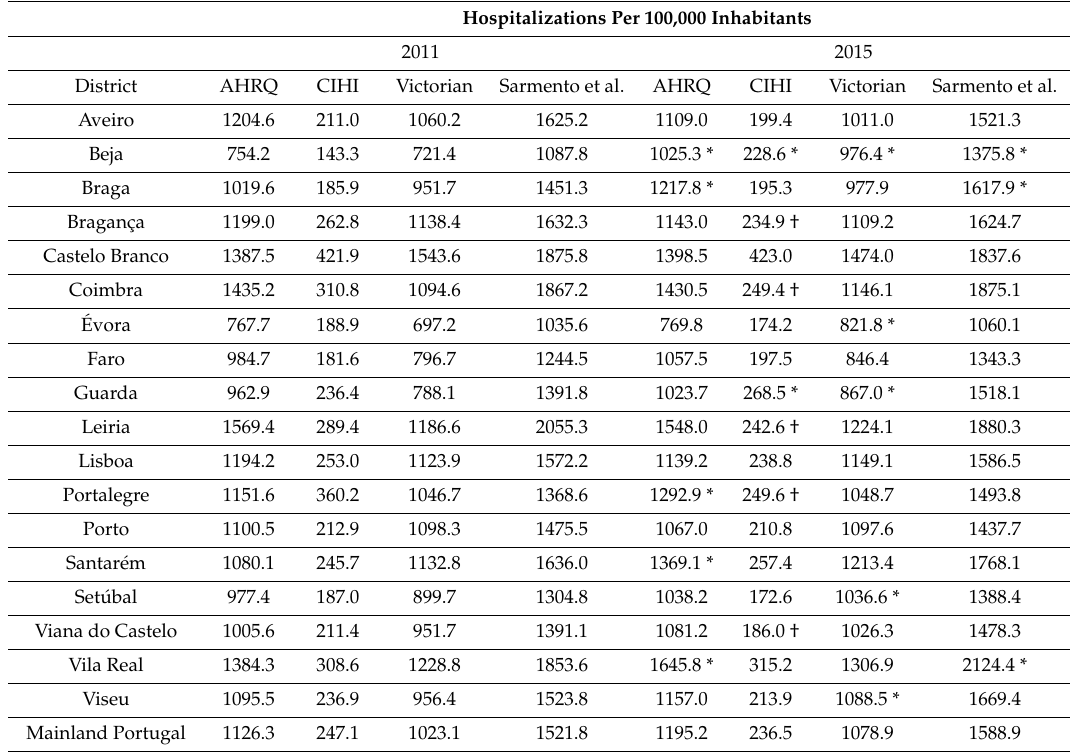
Table 3. Age–Sex-Adjusted Rate Per District According to Four Di ff erent Methods in 2011 and 2015 (Per 100,000 Inhabitants).